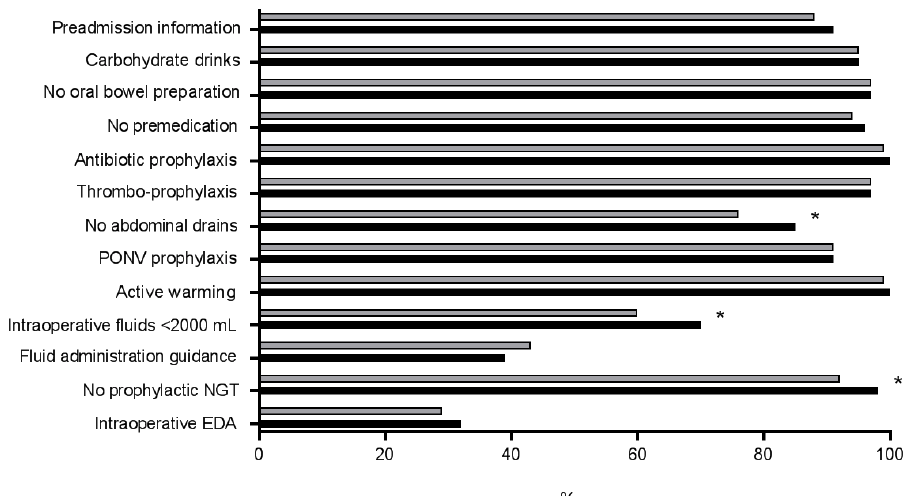
Figure 1. Enhanced Recovery After Surgery (ERAS) compliance. Comparison of compliance to modifiable pre- and intraoperative ERAS-related items among patients with fast return to normal dietary intake (within POD 2, black bars) and patients with delayed tolerance of normal diet beyond POD 2 (grey bars). Premedication = administration of long-acting sedative medication, PONV: postoperative nausea and vomiting, NGT: nasogastric tube; EDA: epidural analgesia. * Indicates statistical significance ( p < 0.05).